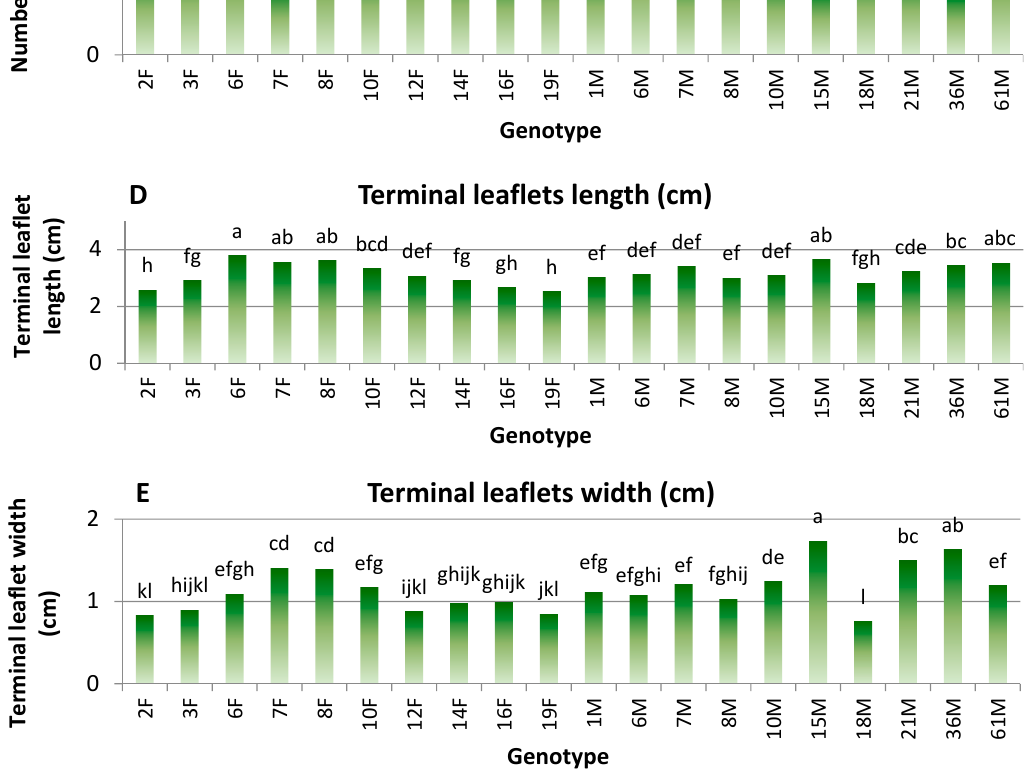
Figure 6. Mean values for 5 out of 13 morphological traits of ornamental interest [leaf length (cm), leaf width (cm), number of leaflets, terminal leaflets length (cm) and terminal leaflets width (cm)] measured on the 20 selected genotypes of P. lentiscus var. Chia. The means of the remaining 8 traits are presented in the Supplementary Table S5. Different letters in columns for each of the traits indicate statistically significant differences according to Duncan’s multiple range test at p ≤